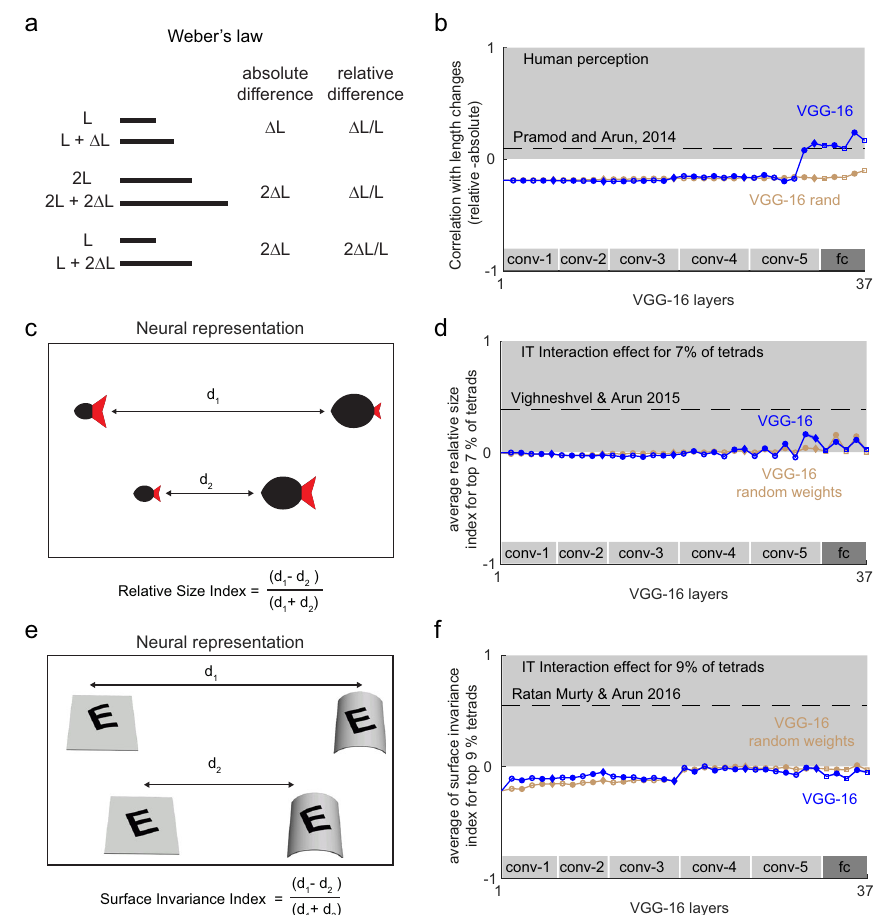
Fig. 4 Relational properties in deep networks. a Example illustrating the Weber ’ s law for line length. Although the original statement of Weber ’ s law is that the just-noticeable difference in length will depend on the baseline length, previous studies have shown that it also applies to perceptual distances 23 . In this formulation, the perceptual distance across pairs of lines differing in length will be more correlated with relative changes in length rather than absolute changes in length. b To calculate a single quantity that measures adherence to Weber ’ s law, we calculated the correlation between distances and relative changes in length and subtracted the correlation between distances with absolute changes in length (see the “ Methods ” section). A positive difference indicates adherence to Weber ’ s law ( grey region ). This difference in correlation is plotted across layers for line length in VGG-16 ( blue ) and a VGG-16 with random weights (brown). The dashed line indicates the value observed during human performing visual search on the same stimuli. c Schematic of the relative size encoding observed in monkey IT neurons 24 . Parts are coloured differently for illustration; in the actual experiments we used black silhouettes. For a fraction of neurons, the distance between two-part objects when both parts covary in size is smaller than the distance when they show inconsistent changes in size. Thus, these neurons are sensitive to the relative size of items in a display. d Relative size index across units with interaction effects (averaged across top 7% tetrads, error bars representing s.e.m.) across layers of the VGG-16 network ( blue ) and a VGG-16 with random weights ( brown ). The dashed line shows the strength of the relative size index estimated from monkey IT neurons on the same set of stimuli 24 . e Schematic of the surface invariance index observed in monkey IT neurons 25 . For a fraction of neurons, the distance between two stimuli with congruent changes in pattern and surface curvature is smaller than between two stimuli with incongruent pattern/surface changes. Thus, these neurons decouple pattern shape from surface shape. f Surface invariance index across units with interaction effects (averaged across top 9% pattern/surface tetrads, error bars representing s.e.m.) across layers of the VGG-16 network ( blue ) and a VGG-16 with random weights ( brown ). The dashed line depicts the surface invariance index estimated from monkey inferior temporal neurons on the same set of stimuli 25